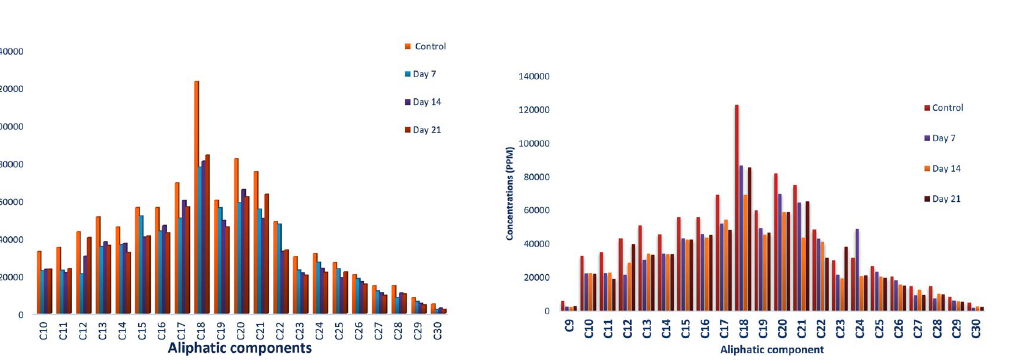
Fig. 2. Concentrations of Aliphatic compounds in residual crude oil from Bacillus cereus culture fluid.